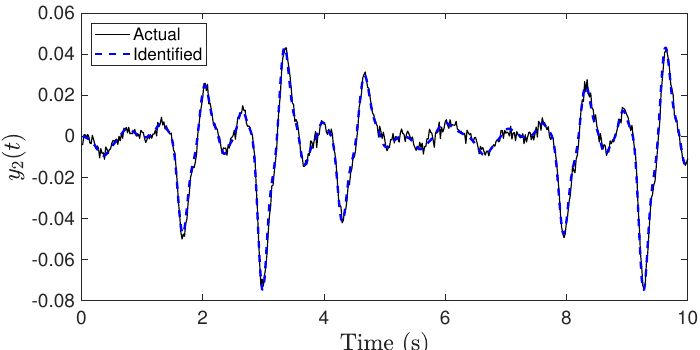
Figure 6. Time response comparison under noise (SNR = 10 dB) for Example 1.